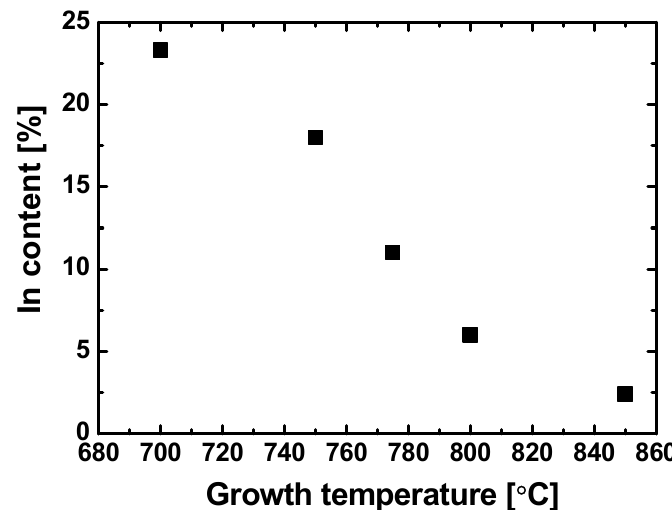
Figure 2. The relationship between the In content and growth temperature.